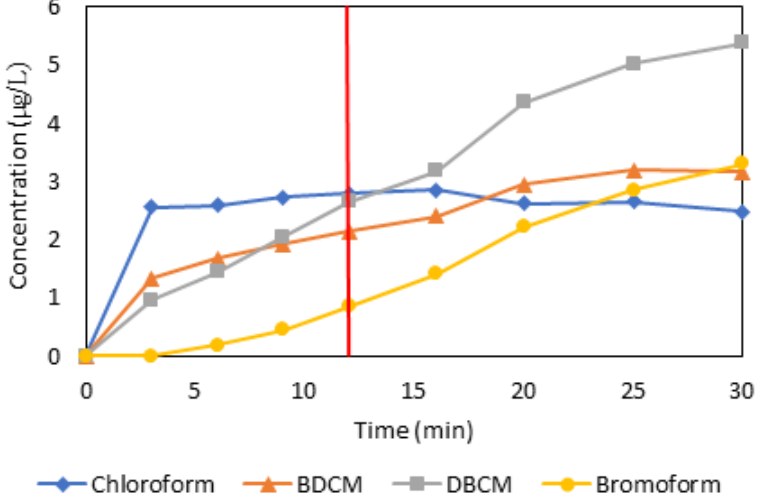
Figure 5. The concentration of individual THMs during BC (red line indicates the estimated time when breakpoint reaction is when breakpoint reaction is complete).